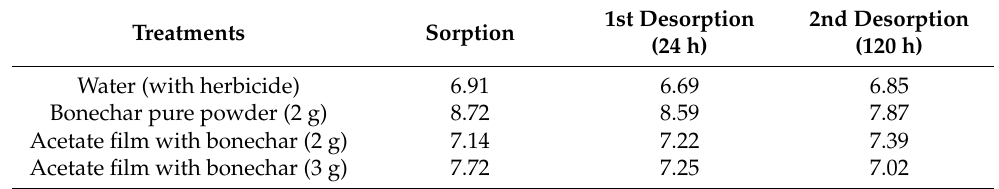
Table 4. Changes in pH of the water during the sorption and desorption study of metribuzin in the water with